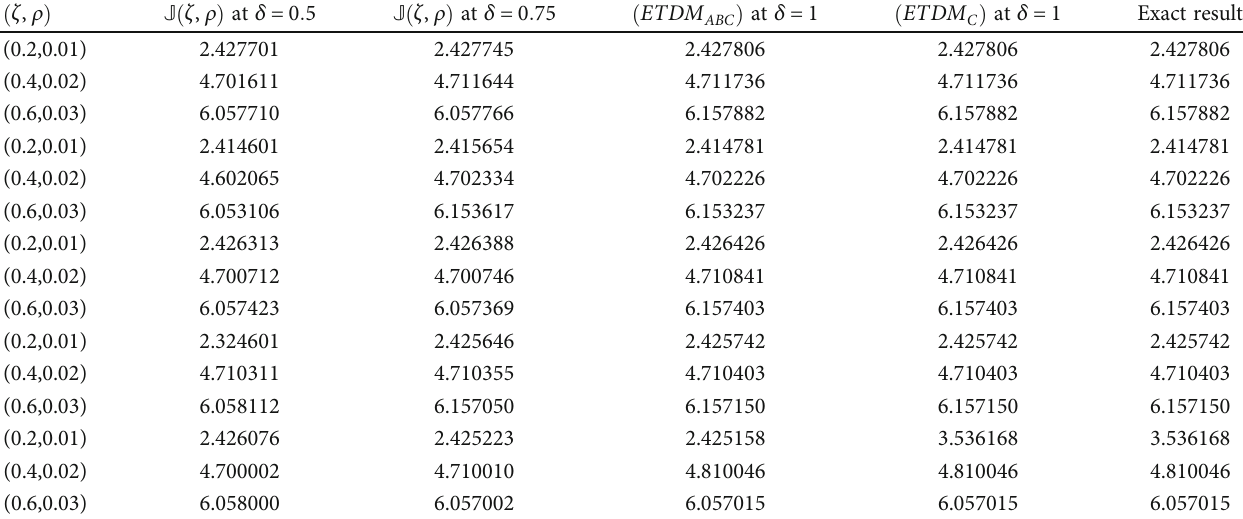
Table 1: Proposed method solution for J ð ζ , ρ Þ at di ff erent fractional orders of problem 1.